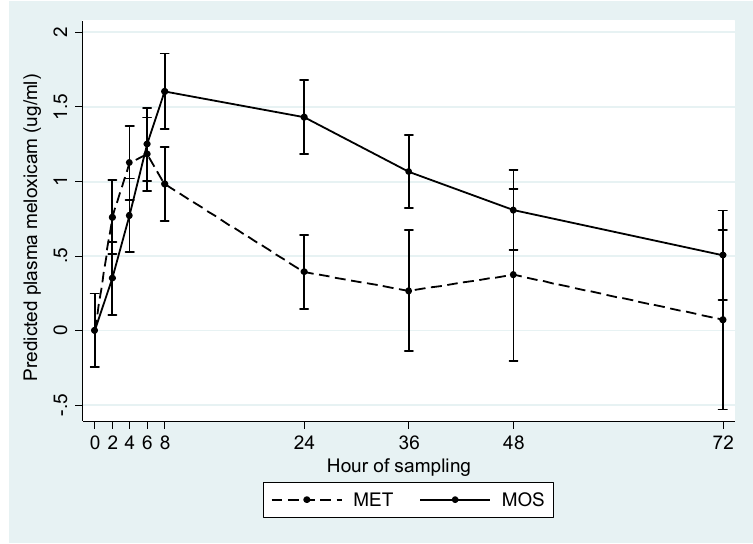
Figure 1. Predicted mean plasma meloxicam concentration ( µ g / mL) in cows treated orally (MOS) or subcutaneously (MET) after